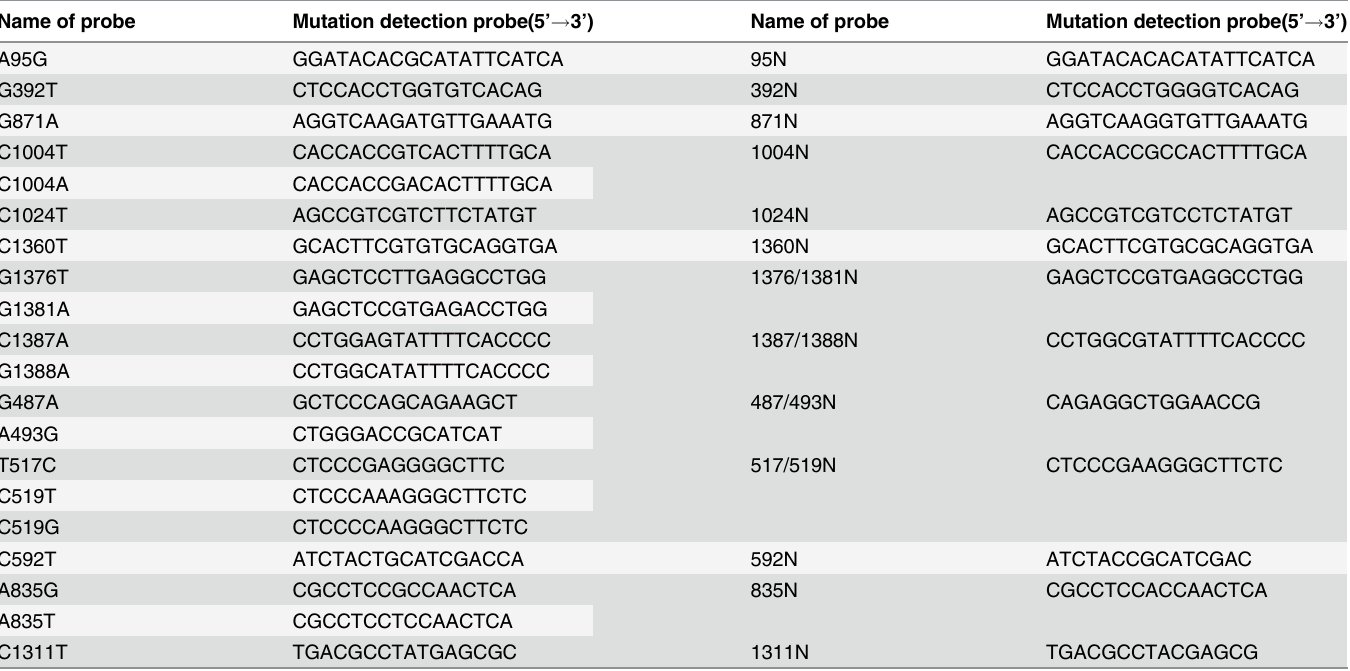
Table 2. G6PD gene mutation detection